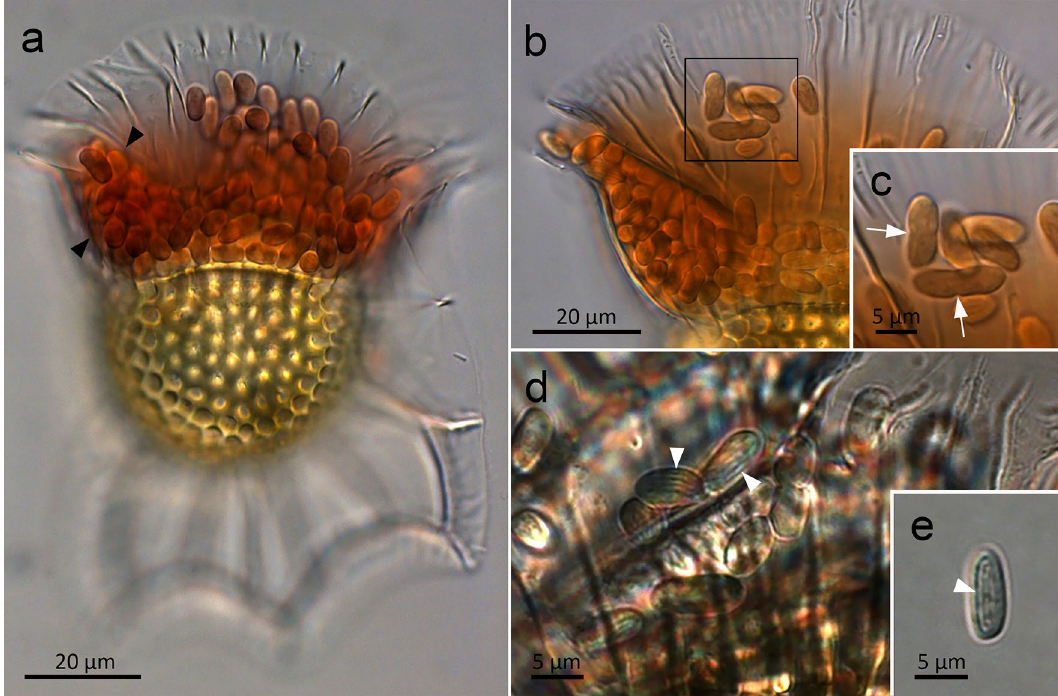
Figure 1. Micrographs of live cyanobacterial symbionts (cyanobionts)-dinoflagellate Ornithocercus host consortium. ( a ) O. magnificus with numerous cyanobionts present in the upper and lower girdle lists (black arrowheads) of the cingulum termed the symbiotic chamber. ( b ) O. steinii with numerous cyanobionts inhabiting the symbiotic chamber. ( c ) Enlargement of the area indicated by the box in 1b showing